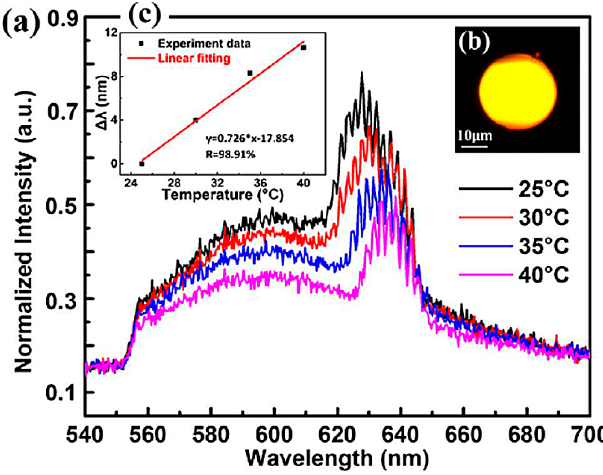
Figure 14. Relationship between the normalized intensity and wavelength at different temperatures. Inset: dependence of the wavelength shift on the temperature. [Reprinted/Adapted] with permission from ref [19], [OSA].